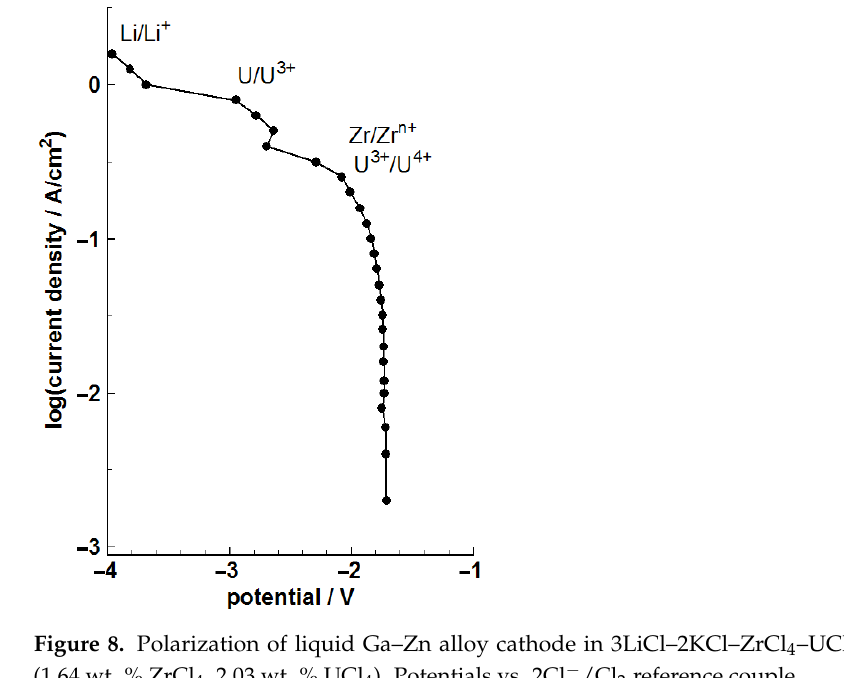
Figure 7. Polarization of liquid Ga–Zn, Ga–Sn and Ga–In cathodes in 3LiCl–2KCl based melts containing uranium chloride at 541 °C (2.08 wt. % UCl 3 ); 596 °C (0.90 wt. % UCl 3 ) and 550 °C (0.90 wt. % UCl 3 ), respectively. Potentials vs. 2Cl – /Cl 2 reference couple. Polarization curve for solid tungsten cathode is shown for comparison.